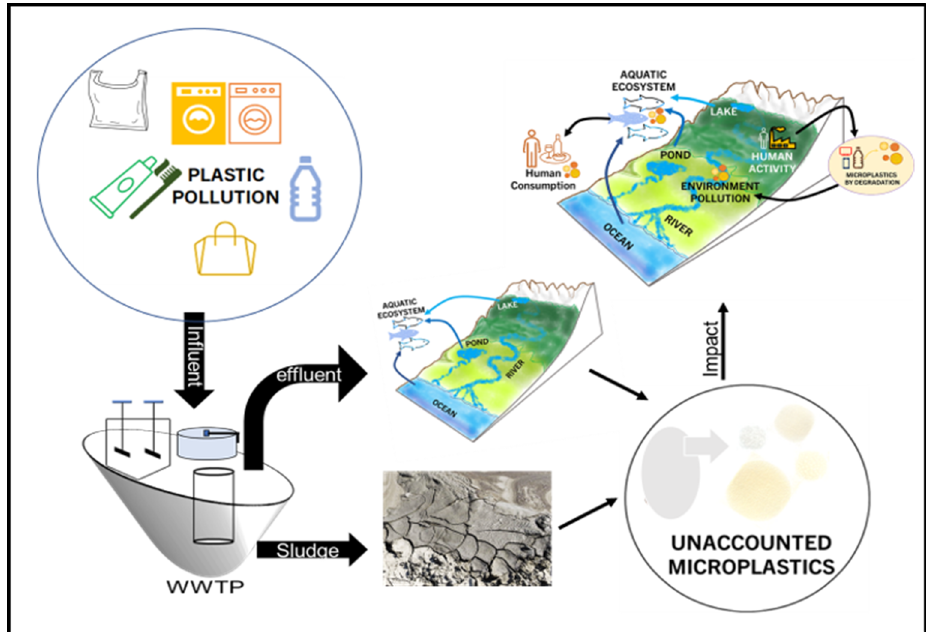
Figure 2. Schematic representation of “unaccounted MPs” in the environment. EMB: Number of MPs in Influent > Number of MPs in Effluent + Number of MPs in Sludge.